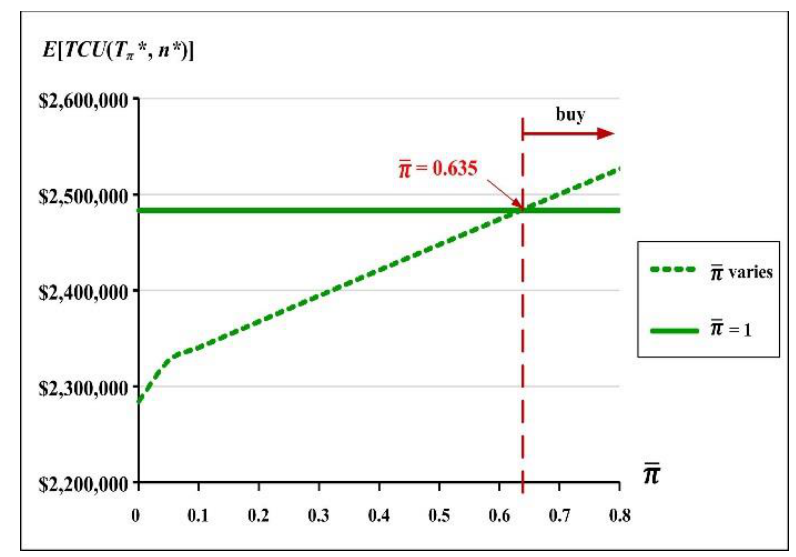
Figure 6. Effect of differences in  on management’s make-or-buy decision making